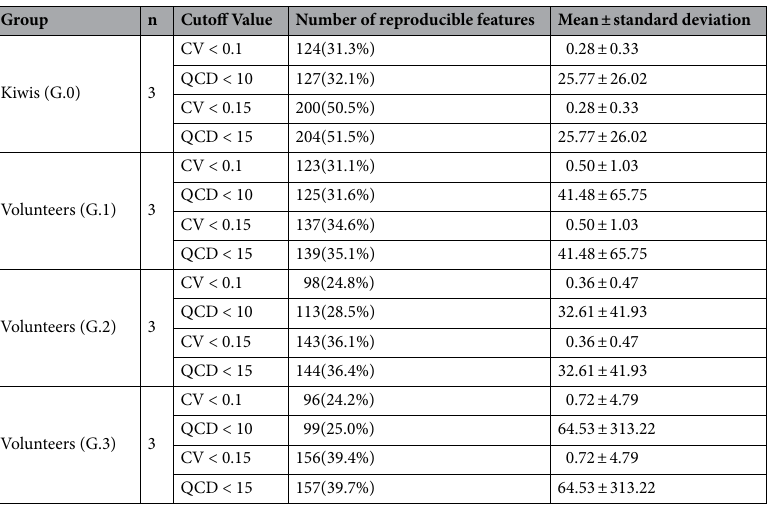
Table 1. The number of reproducible features for inter-MR analysis across volunteers and kiwis out of a total of 396. The values displayed on the table were means within each group. “Mean ± Standard Deviation” was calculated from mean CV or mean QCD values within each group. G.0 represents the three kiwis, while G.1–G.3 represent the three group volunteers in 6th–10th, 11th–15th, and16th–20th day of physiological cycle